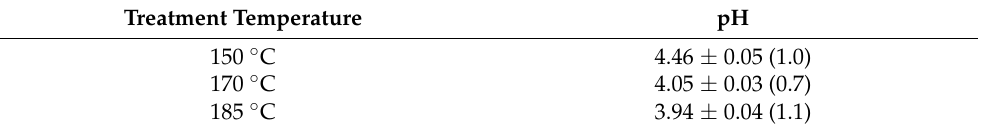
Table 3. pH of the HTT process water (mean ± standard deviation (coefficient of variation [%])).